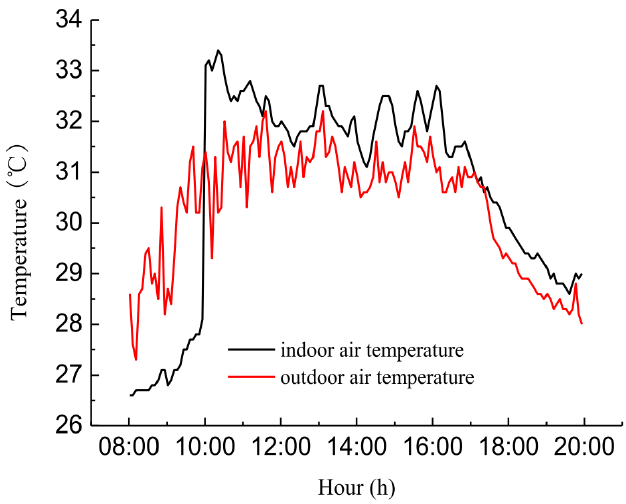
Figure 18. Indoor and outdoor temperature variation time course [110].